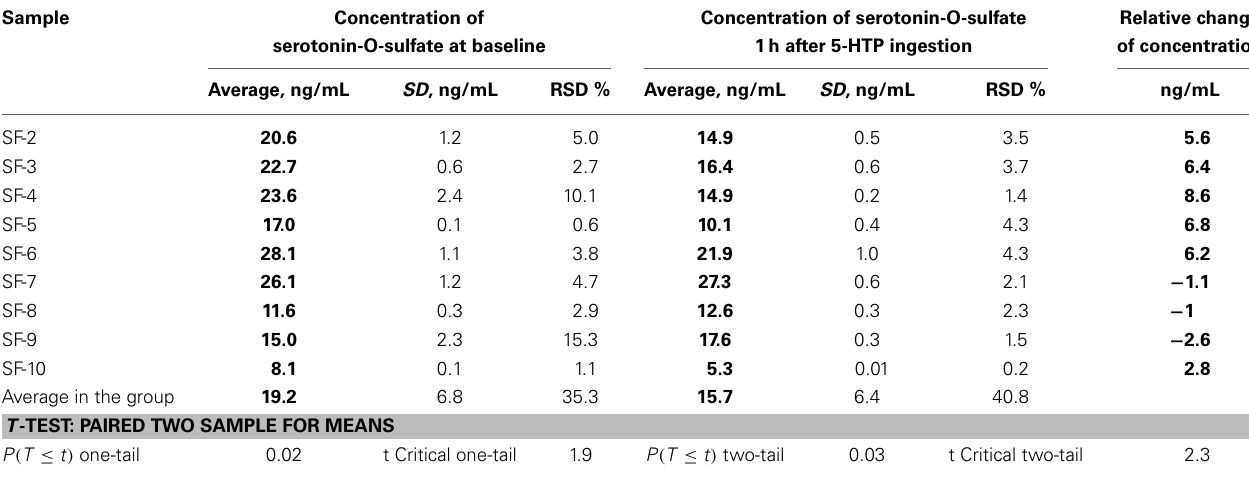
Table 7 | Concentrations of plasma 5-HT-SO4 obtained from the study subjects and data of statistical analysis. Sample Concentration of Concentration of serotonin-O-sulfate Relative change serotonin-O-sulfate at